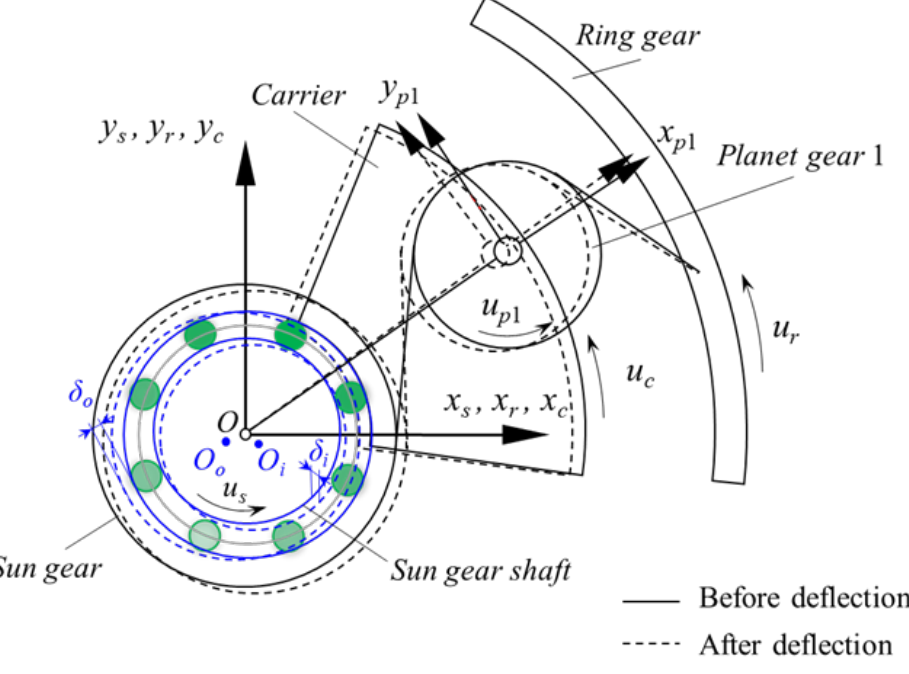
Figure 2. Schematic diagram of the ball bearing with time-varying loads and rotating speed.